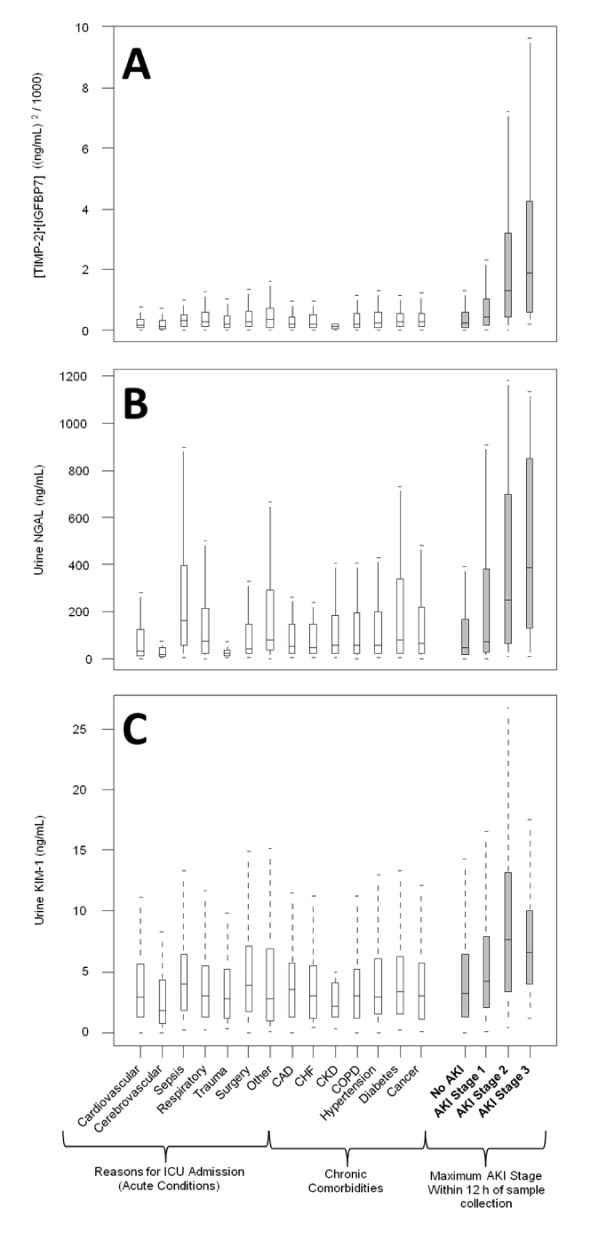
Discrimination between non-AKI conditions and AKI of different severities for (A) urine [TIMP-2]·[IGFBP7], (B) urine NGAL, and (C) urine KIM-1. Open boxes represent Sapphire subjects who did not have AKI (of any stage) within seven days. Shaded boxes represent Sapphire subjects stratified by maximum AKI stage within 12 hours of sample collection. Boxes and whiskers show interquartile ranges and total observed ranges (censored by 1.5 times the box range), respectively. Samples were collected within 18 hours of enrollment. AKI, acute kidney injury; IGFBP7, insulin-like growth factor-binding protein 7; KIM-1, kidney injury marker-1; NGAL, neutrophil gelatinase-associated lipocalin; TIMP-2, tissue inhibitor of metalloproteinases-2.